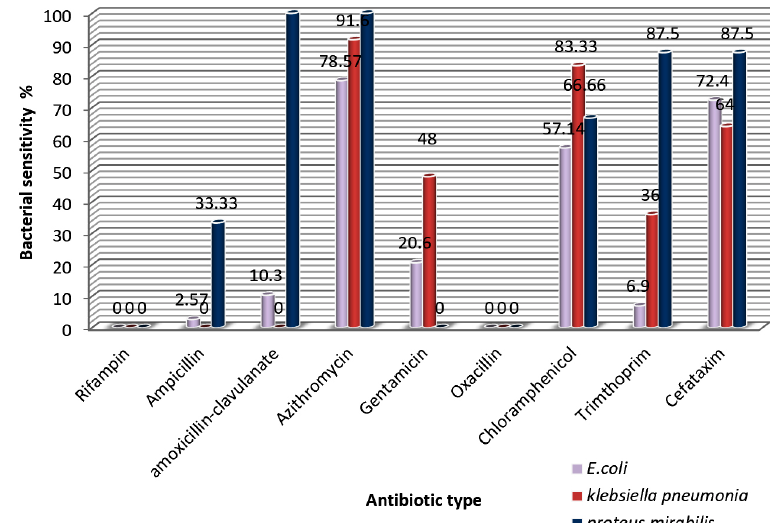
Fig. 2. Distribution of Antibiotics Sensitivity of Gram Negative Bacteria Isolated from children with Table 1. Antibiotic discs used in the current study and the global antibiogram activity Antibiotics